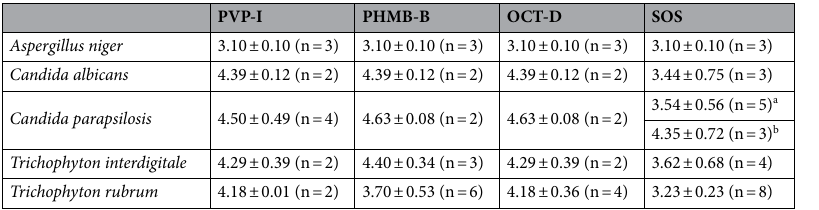
Table 3. Results of antiseptic solution testing for antifungal activity, presented in log reduction values. Values of log 10 reduction mean and standard deviation. In parentheses; n number of valid tests. PVP-I povidone- iodine, PHMB-B polyhexamethylene biguanide-betaine, OCT-D octenidine dihydrochloride, SOS super- oxidized solution. a Tested compound at 80% (according to the protocol); b Tested compound at